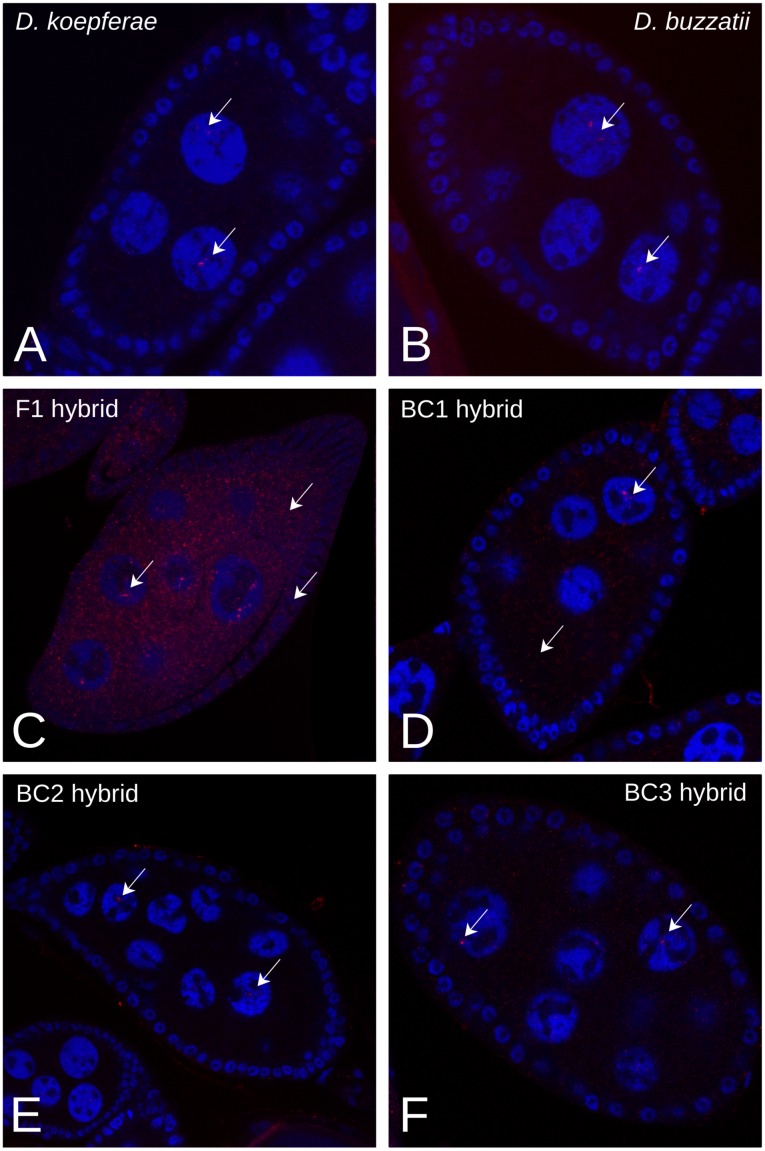
FISH of Helena RNA expression in ovaries.Red staining are Helena transcripts, blue staining is DAPI (cells nuclei). Arrows mark the presence of Helena transcripts. A)
D. koepferae, B)
D. buzzatii, C) F1 hybrid, D) BC1 hybrid, E) BC2 hybrid, F) BC3 hybrid.